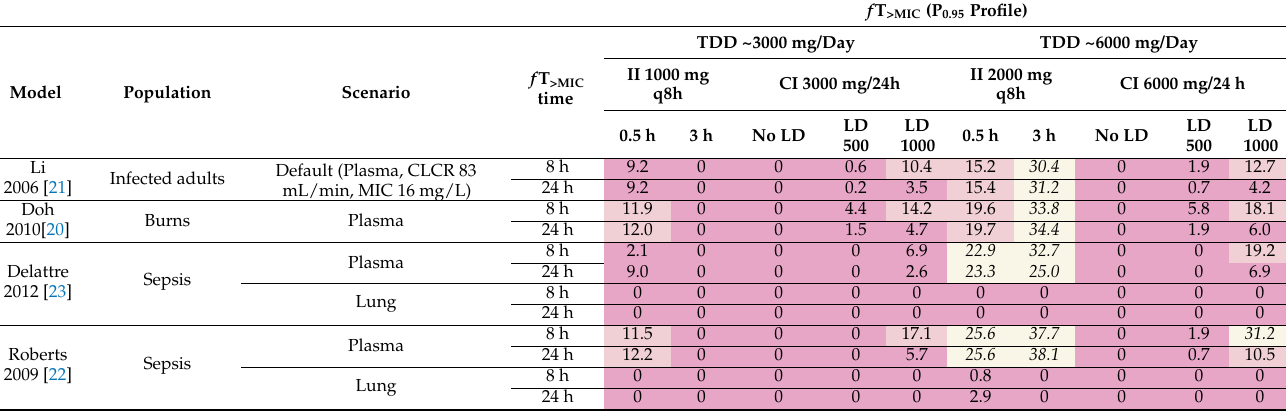
Table 2. f T >MIC at 8 h and 24 h after start of therapy based on PKPD profiles covering 95% of